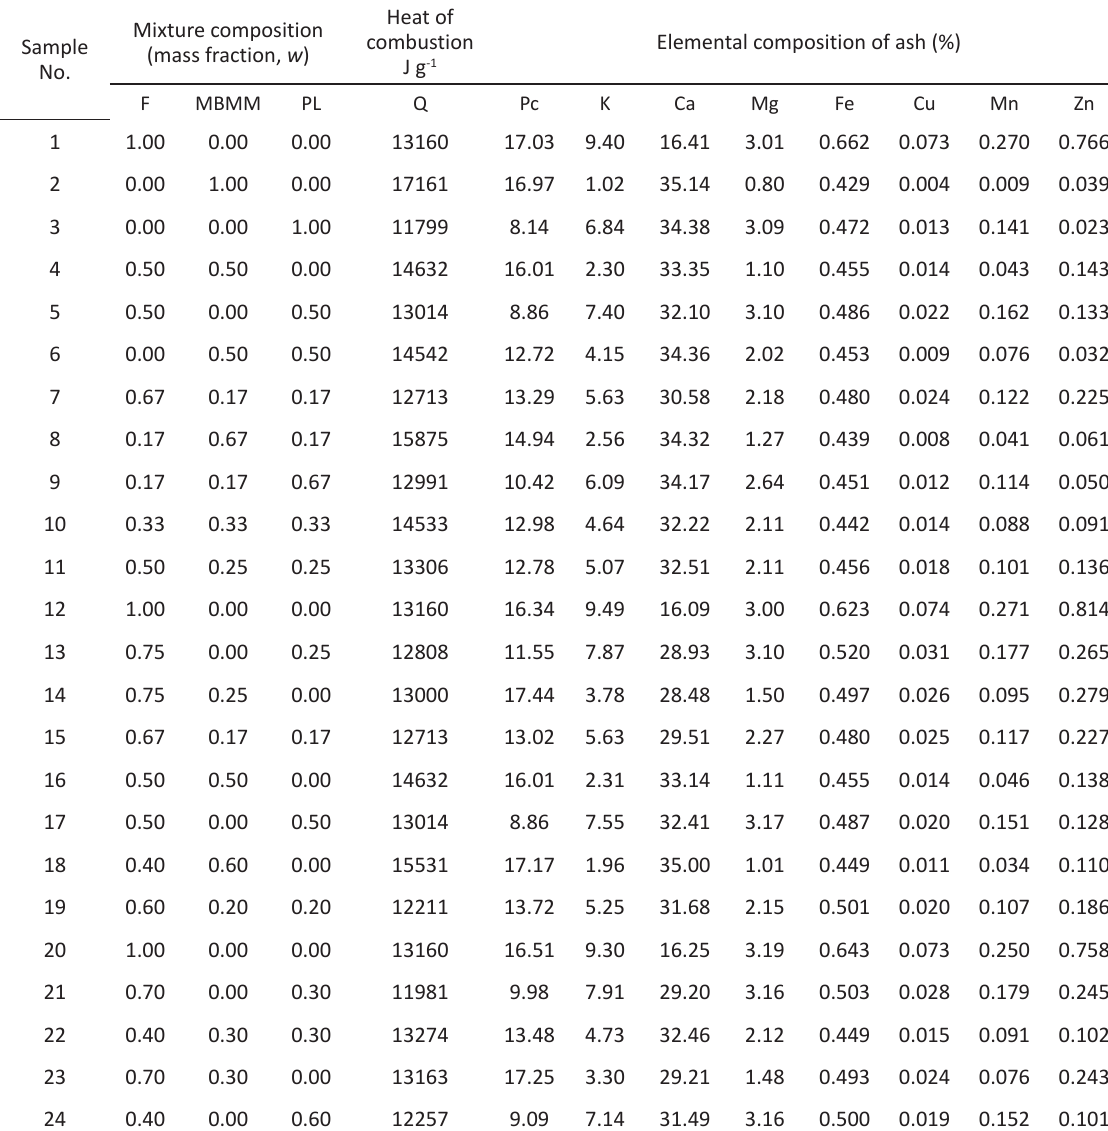
Table 2. The composition of the mixtures, calorific value, content of macro- and micronutrients in the resulting ashes Sample